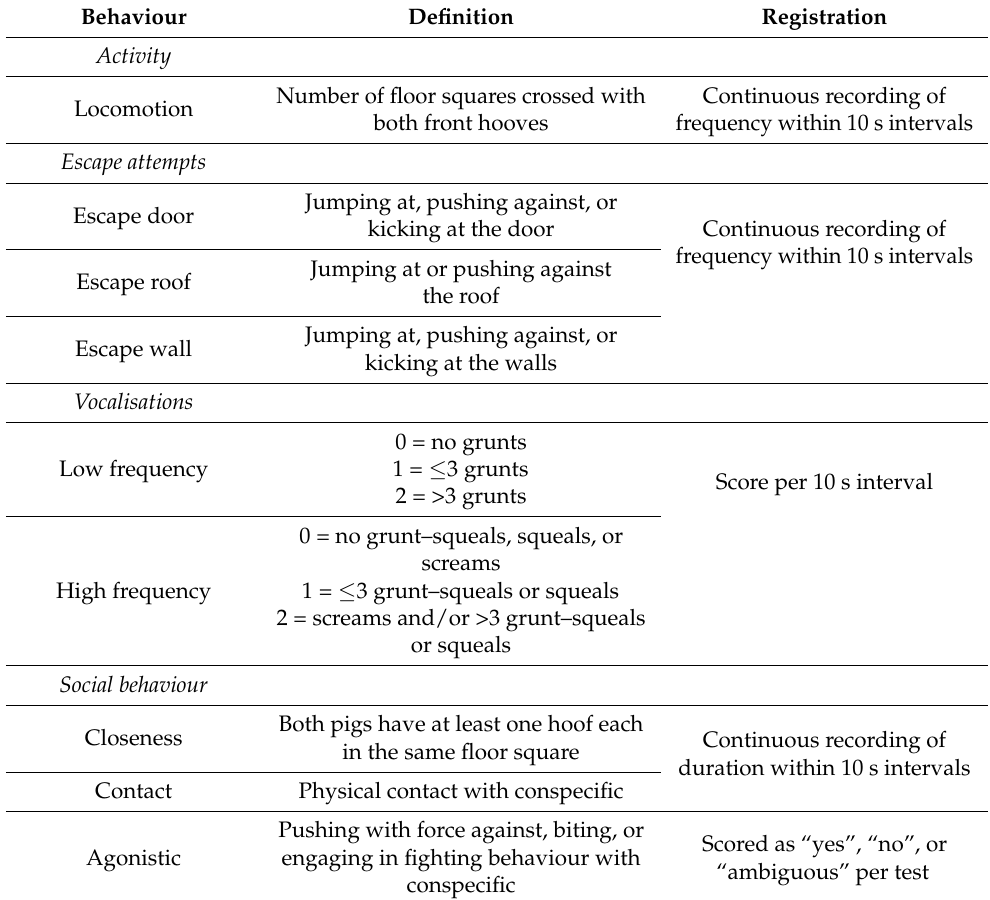
Table 2. Ethogram used for observations of pig behaviour inside the foam box. Activity and escape attempts were recorded on an individual pig basis. Vocalisations and social behaviours were recorded on a pig pair basis. Behaviour Definition Registration Activity Number of floor squares crossed with Continuous recording of Locomotion both front hooves frequency within 10 s